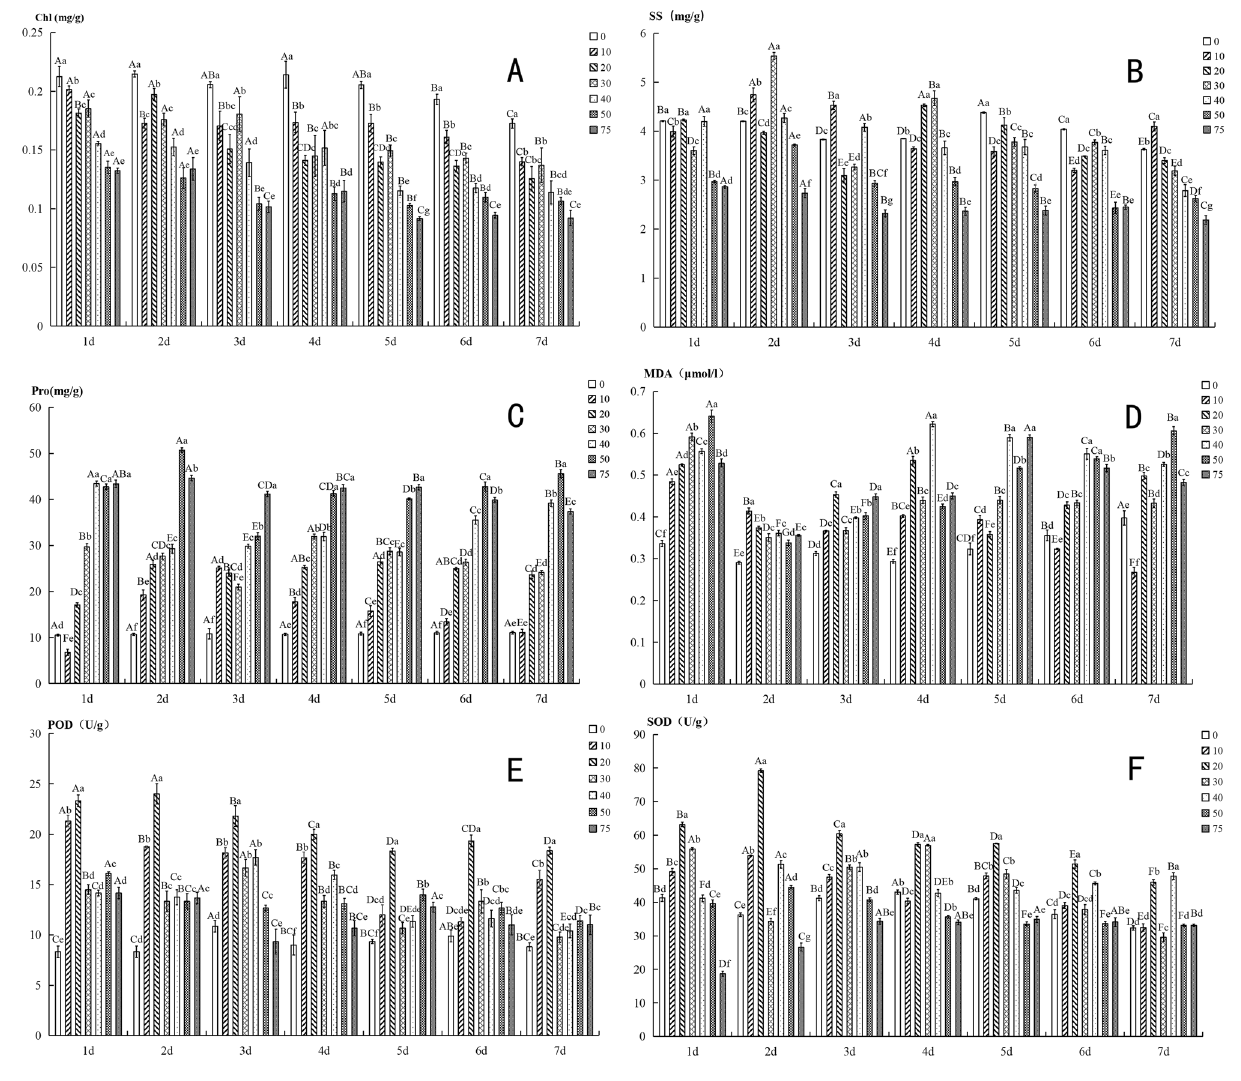
Figure 2. Differences in physiological properties among Hg addition concentrations. ( A ) Chlorophyll (Chl); ( B ) soluble sugar (SS); ( C ) proline (Pro); ( D ) malondialdehyde (MDA); ( E ) peroxidase (POD); ( F ) superoxide dismutase (SOD). Each value is showed using the mean of three samples (Mean ± SD ). Different capital letters indicate a significant difference ( p < 0.05) among seven sampling days with the same treatment; different lowercase letters indicate a significant difference ( p < 0.05) among seven Hg treatments in the same day. Vertical bars show the standard error (SD) (n =